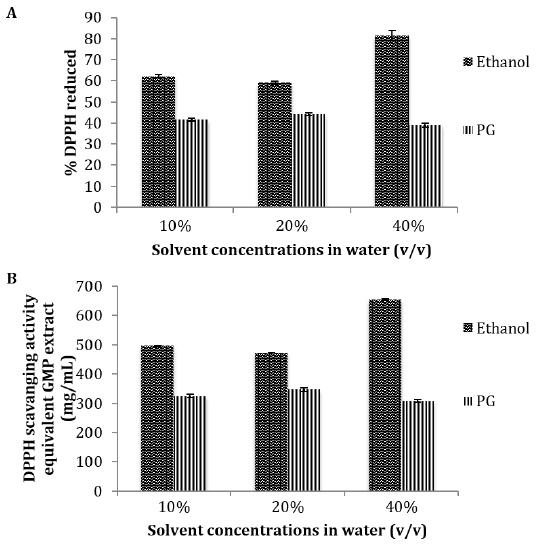
Figure 1. DPPH scavenging activity (% DPPH reduction) ( A ) and its radical scavenging activity equivalent GMP extract (RSGMPE) ( B ) in various ethanol/water or PG/water binary solvent mixtures. Each bar represents the mean  SD of three